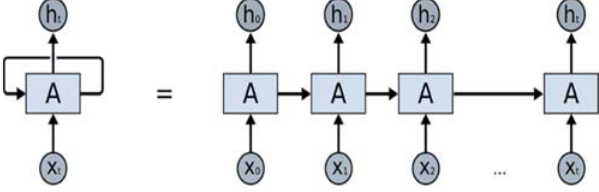
Figure 1. Recurrent neural networks (RNN) and the unfolding in time of the computation.